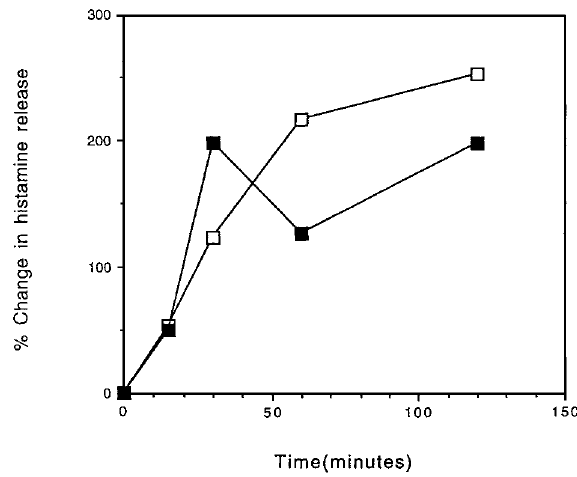
FIG. 3. Spontaneously released histamine in nasal mucosa incubated with SLPI, 150 m M, (– h –) compared with sponta- neously released histamine in the absence of SLPI (– j –). No significant inhibition of histamine release was seen in the absence of IgE-stimulation.